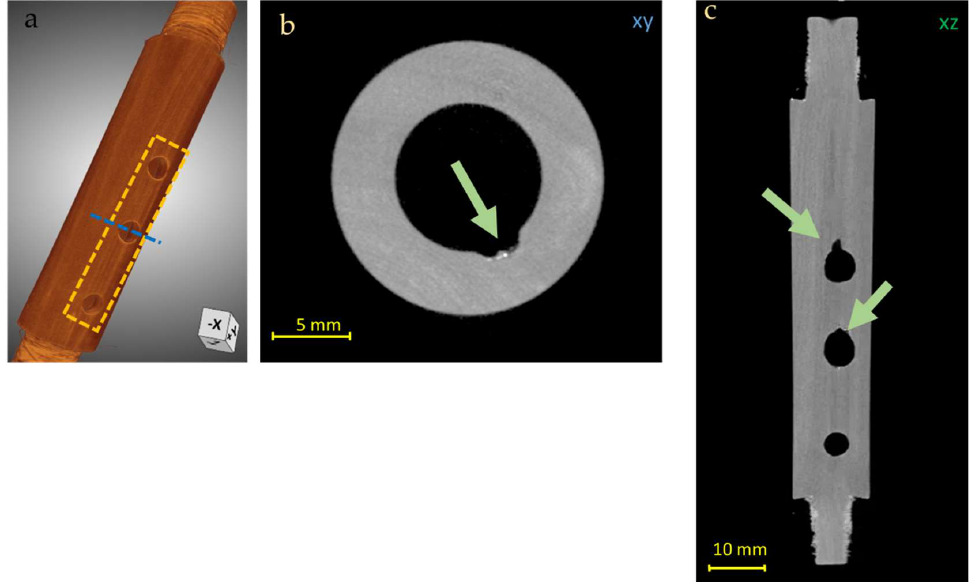
Figure 8. 3D render of the Piccolo Flute body ( a ) and CT horizontal ( b ) and vertical ( c ) slices of the Piccolo Flute body, in which imperfections in the holes are observed (green arrows in ( b , c ), yellow square in ( a )). Blue line in ( a ) indicates the high of the XY slice ( b ).